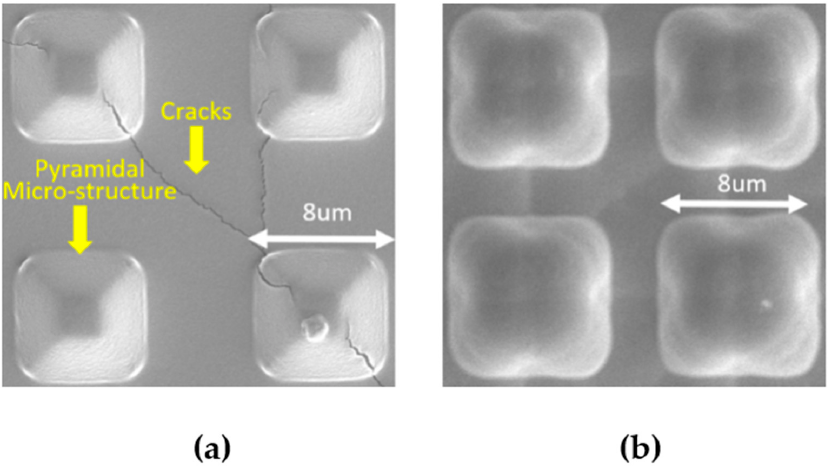
Figure 4. Scanning electron microscope (SEM) photographs of metal films on electrodes ( a ) Electrodes without parylene transition layer ( b ) Electrodes containing the parylene transition layer.